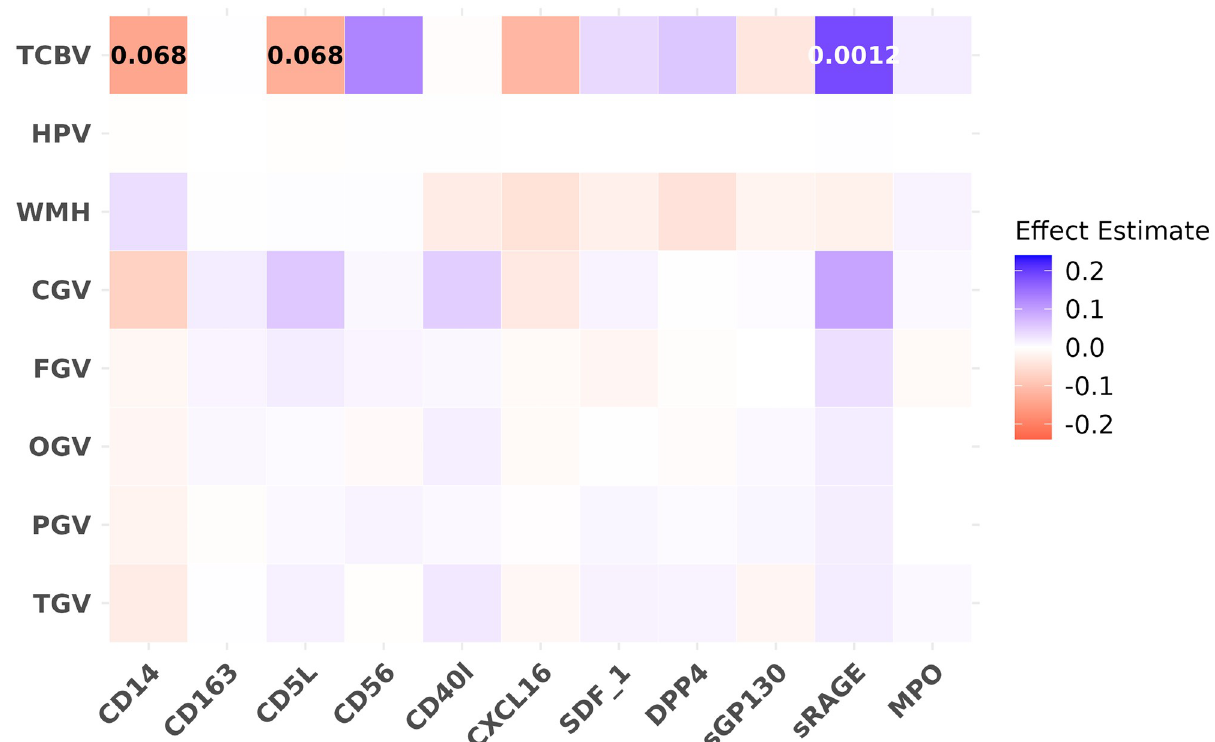
Fig 3. Effect estimates and FDR value for the associations of protein biomarkers with brain MRI measures. Effect estimates are in colors and FDR value (if � 0.1) are labeled as numbers. Protein biomarker predictors were rank normalized to mean 0 and SD 1. Total and regional brain volumes and WMH volume were as percentage of TCV, WMH was also log transformed. Each color block shows the estimated effect for each pair of associations investigated in the primary analyses using linear mixed effect models adjusting for the covariates from Model 1 (age, age 2 , sex, age-sex interaction, and time distance between exam 7 and the MRI